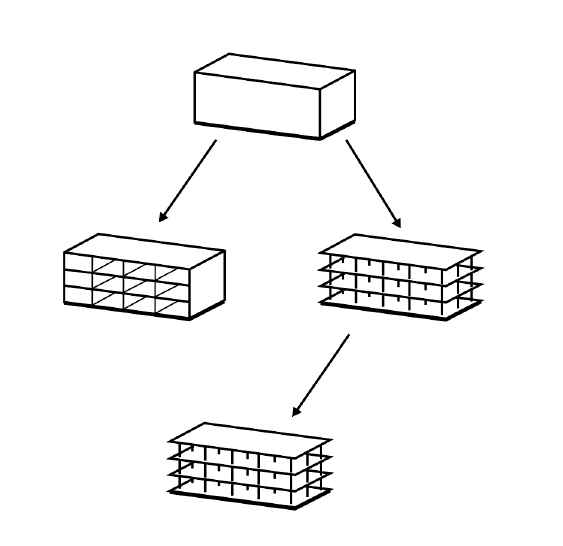
Figure 4. Case study refinement.